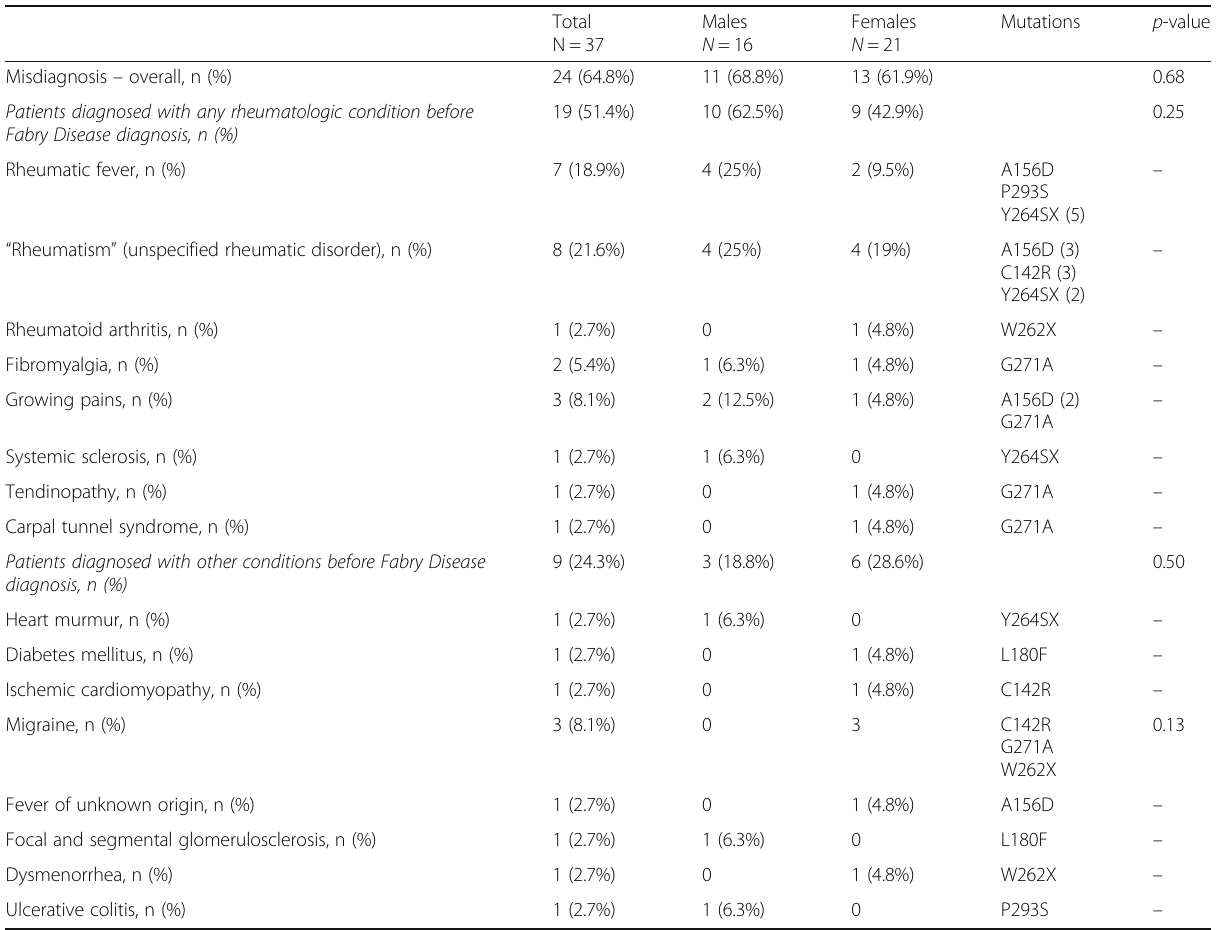
Table 2 Misdiagnosis in Fabry disease patients